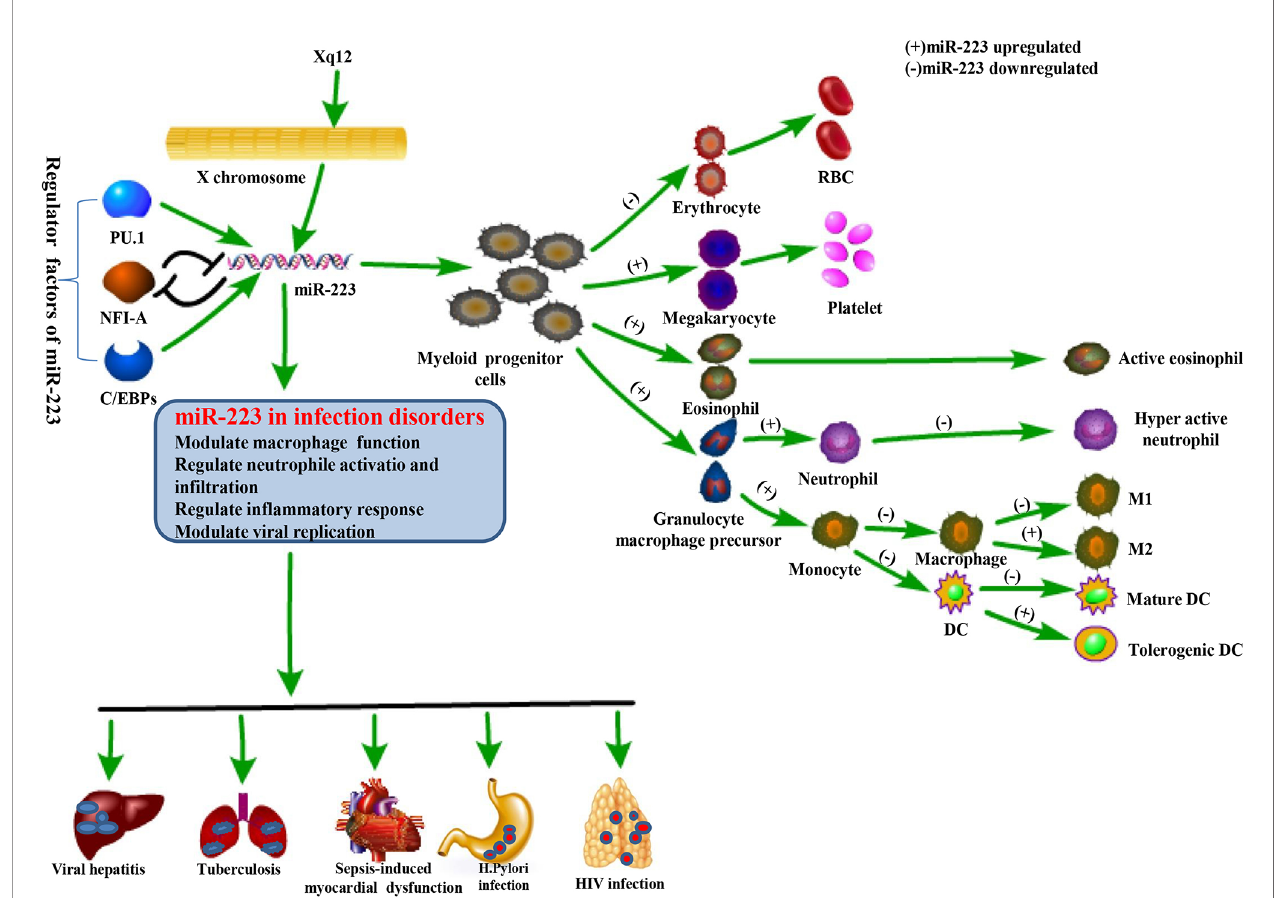
FIGURE 2 | Physiological function of miR-223 and its role in regulating infectious diseases. The miR-223 gene is located on the X chromosome and modulated by several transcription factors including PU.1, C/EBPs, and NFI-A. miR-223 is a powerful regulator in hematopoietic differentiation and immune responses, and is also involved in the pathogenesis of infectious diseases by affecting macrophage function, neutrophil activation and in fi ltration, in fl ammation, and even viral